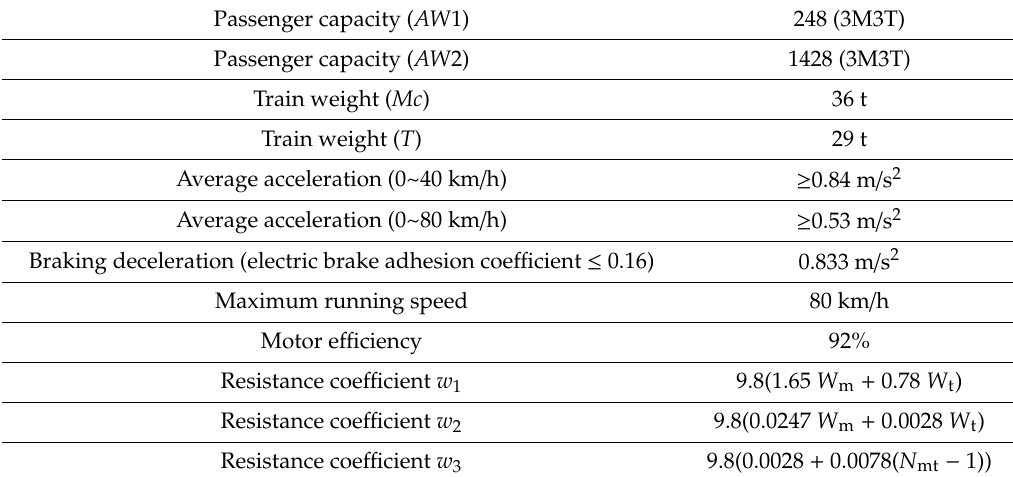
Table 2. Characteristics of the trains operating in Beijing Metro Batong Line.